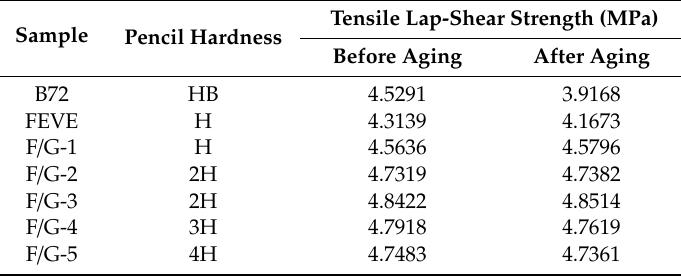
Table 1. Pencil hardness and shear strength of films.